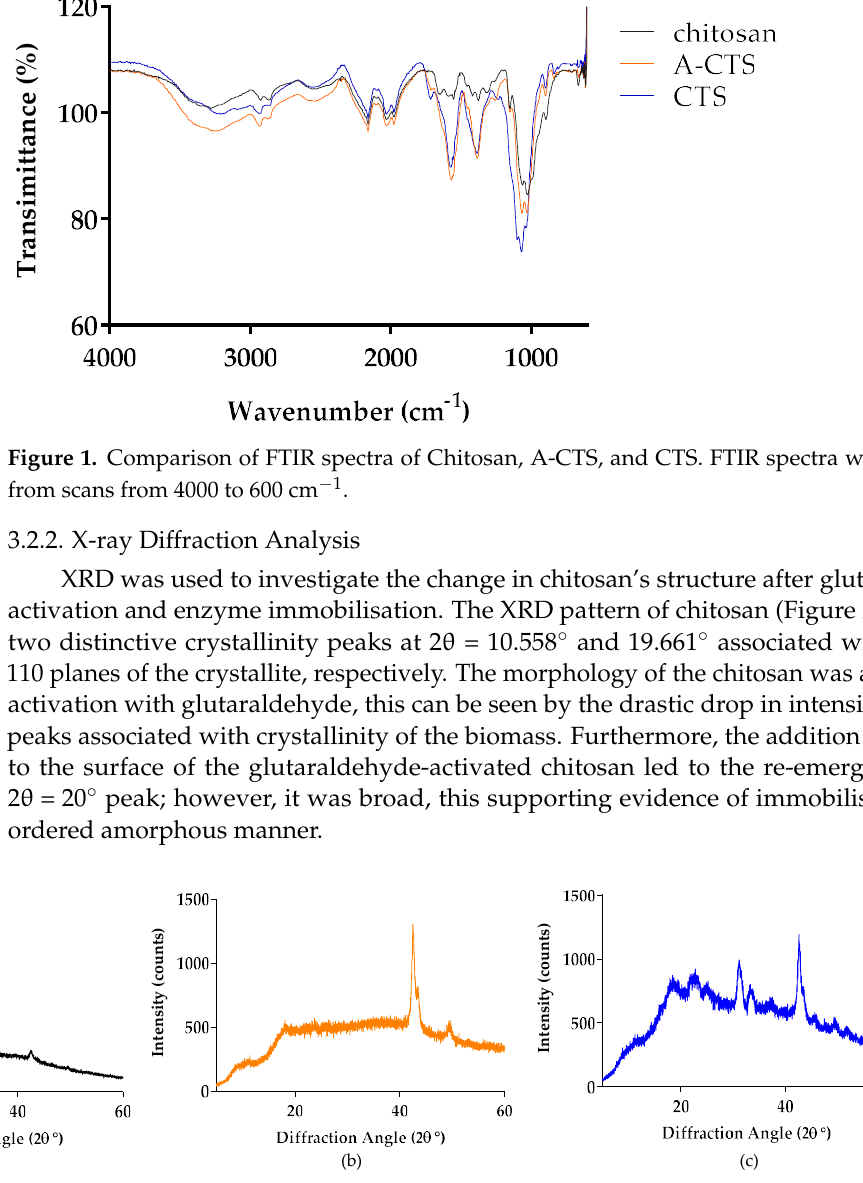
Figure 2. X-ray diffraction patterns of ( a ) chitosan, ( b ) glutaraldehyde-activated chitosan nanopar- ticles, and ( c ) endo-1,4-β-mannanase immobilised on glutaraldehyde-activated chitosan nanoparti- cles.